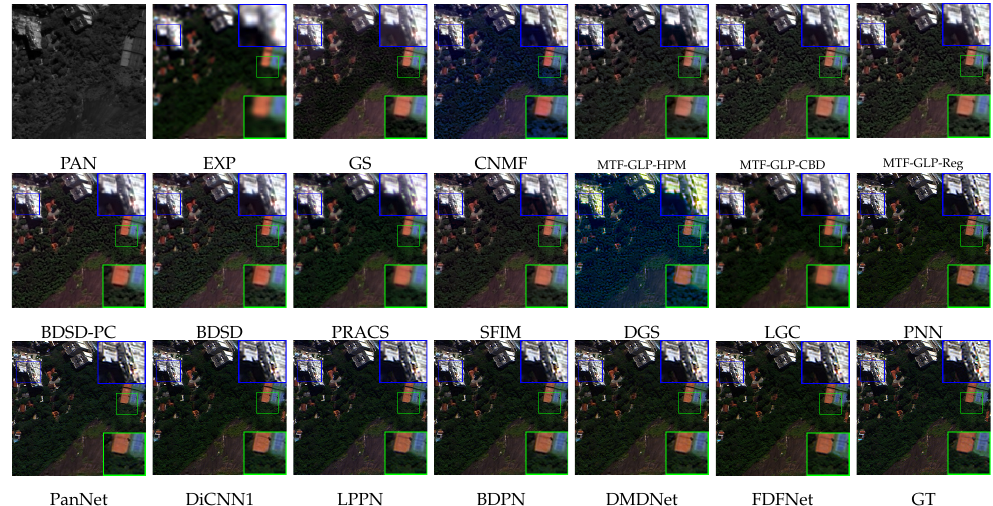
Figure 5. The visual comparisons of fusion results obtained by different methods on a reduced- resolution Rio dataset obtained by WorldView-3 (shown by bands: 1, 3, and 5).